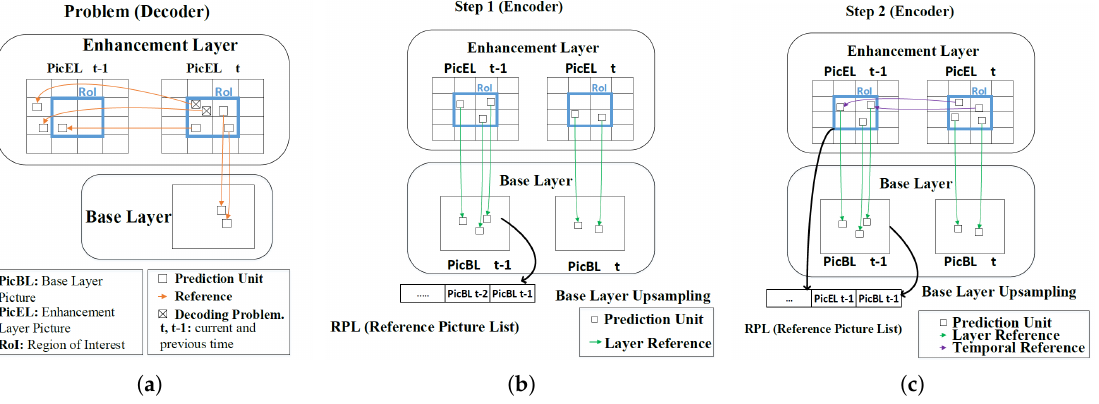
Figure 8. Problem with non-ROI tile references in the SHVC decoder; In Step 1, the EL refers only to